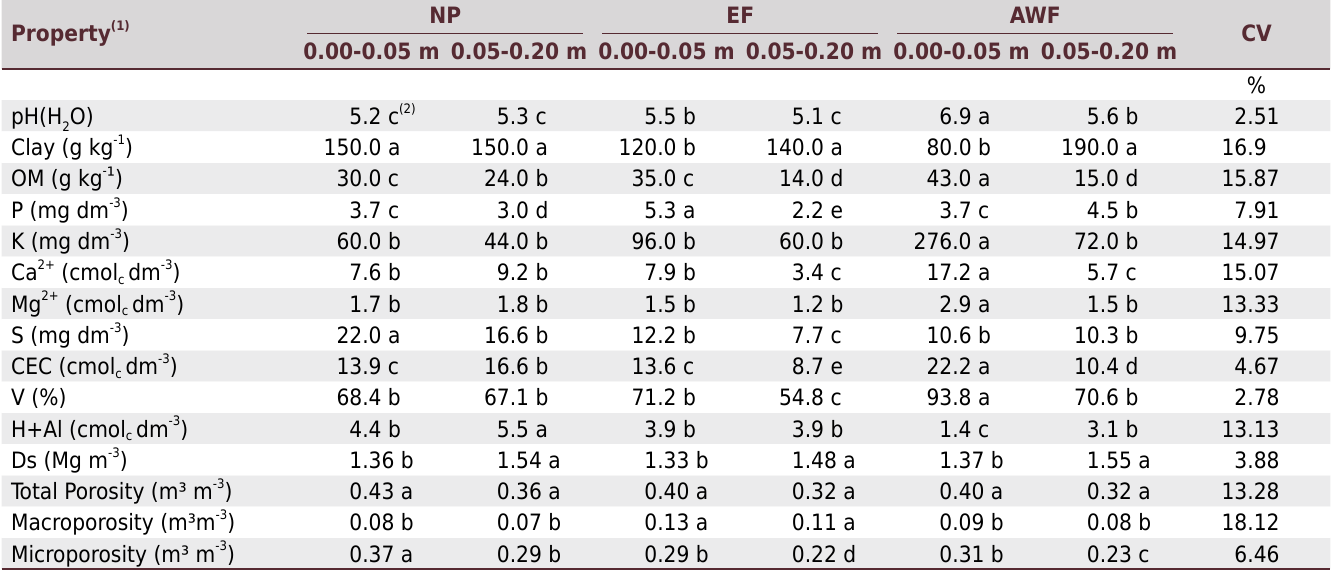
density (Ds, volumetric rings); total porosity, macro, and microporosity determined by weight difference after capillary saturation. H+Al = potential acidity; V% = base saturation. (2) Means followed by the same letter in the line are not significantly different based on the Scott-Knott test